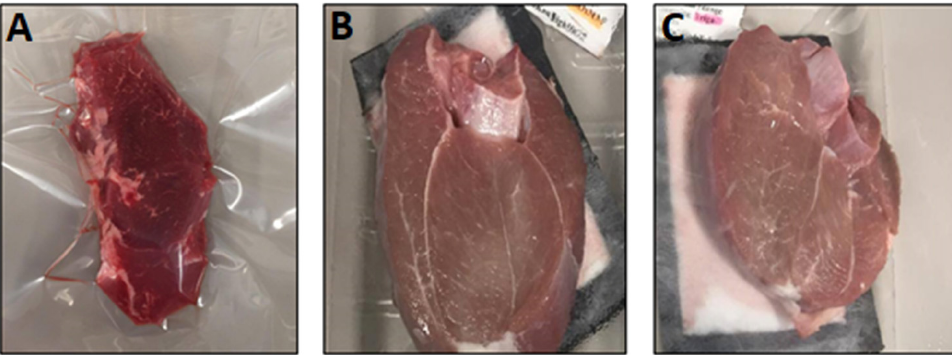
Figure 2. Visual comparison of Vastus lateralis from a Composite sheep finished on standard pelleted diet with grain and hay and packed in ( A ) vacuum skin packaging; ( B ) HioxMAP; or ( C ) TrigasMAP for 10 days at 4 °C.